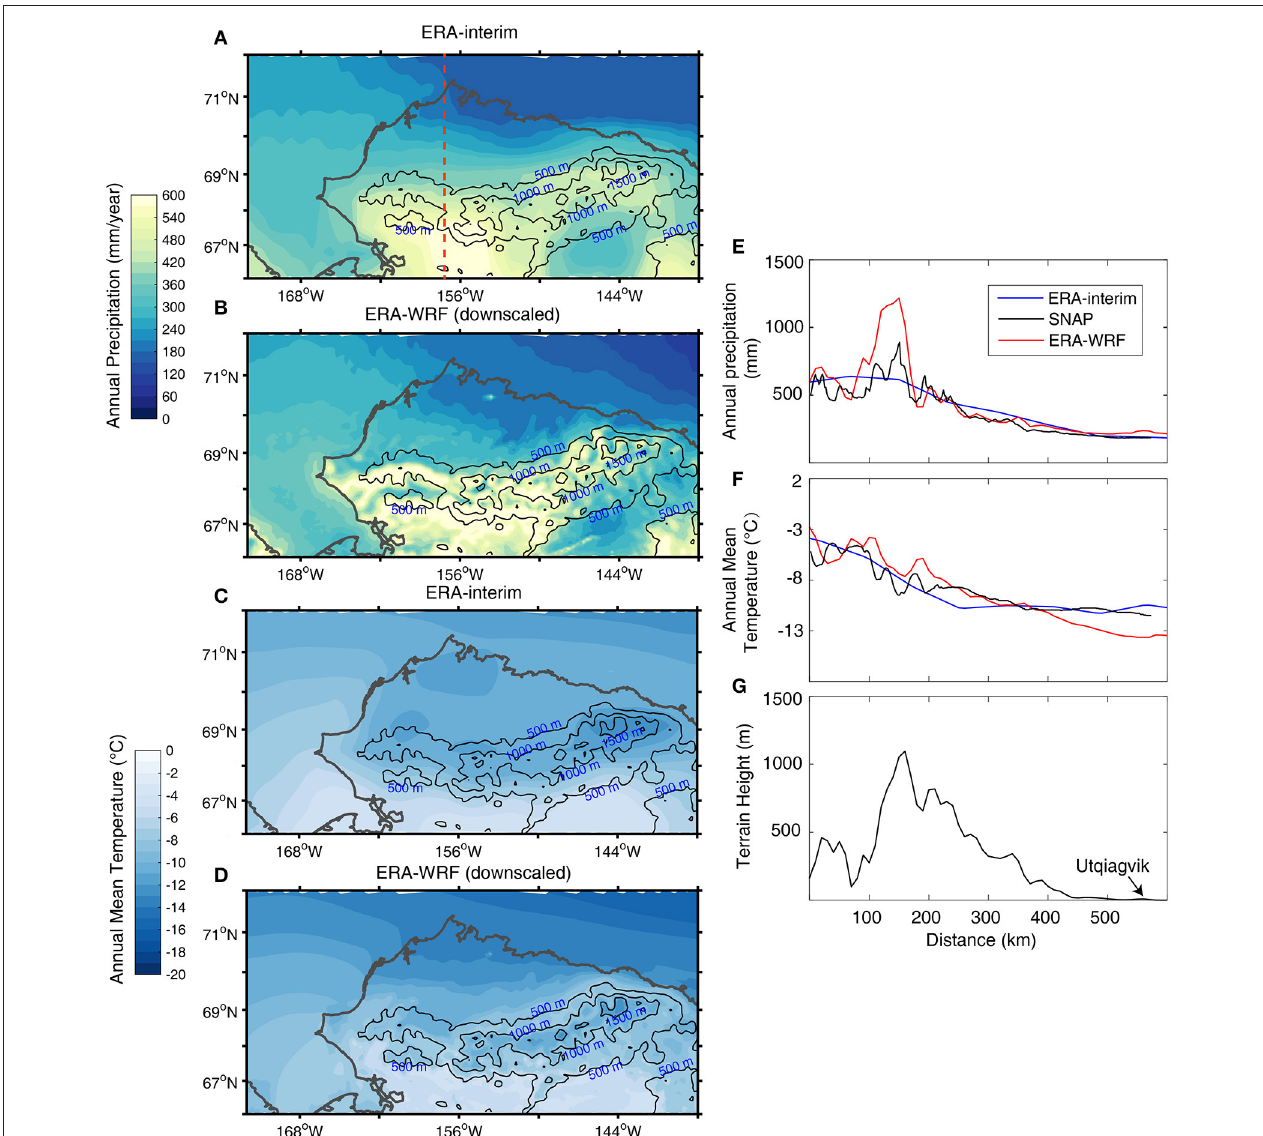
FIGURE 3 | Original (ERA-interim) and downscaled (ERA-WRF) climatology 1980–2015 and elevation contour lines (black lines). Coarse resolution ERA-interim annual precipitation (A) and air temperature (C) compared to downscaled results from the ERA-WRF approach (B,D) . Elevation contour lines in all figures are made from terrain height data in WRF. The annual precipitation (E) and mean temperature (F) distributions on the cross section (red dashed line in A ) from ERA-interim (blue solid lines), SNAP (black solid lines), and ERA-WRF (red solid lines) show how a more detailed topography in ERA-WRF (G) affects the precipitation and temperature